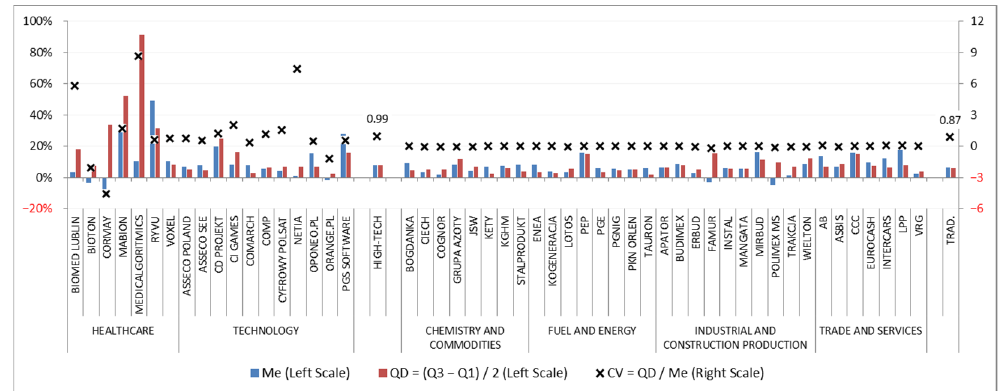
Figure 10. Assessment of total asset variation in the surveyed enterprises . Source: own work.